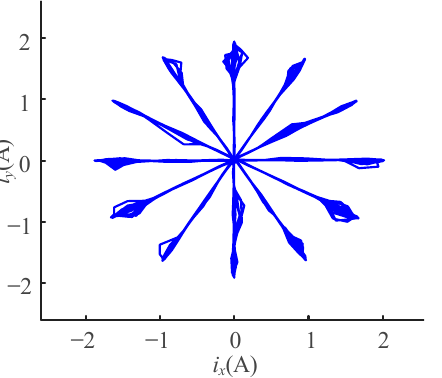
Figure 17. z 1 -z 2 harmonic plane current trace in case of single-switch fault.